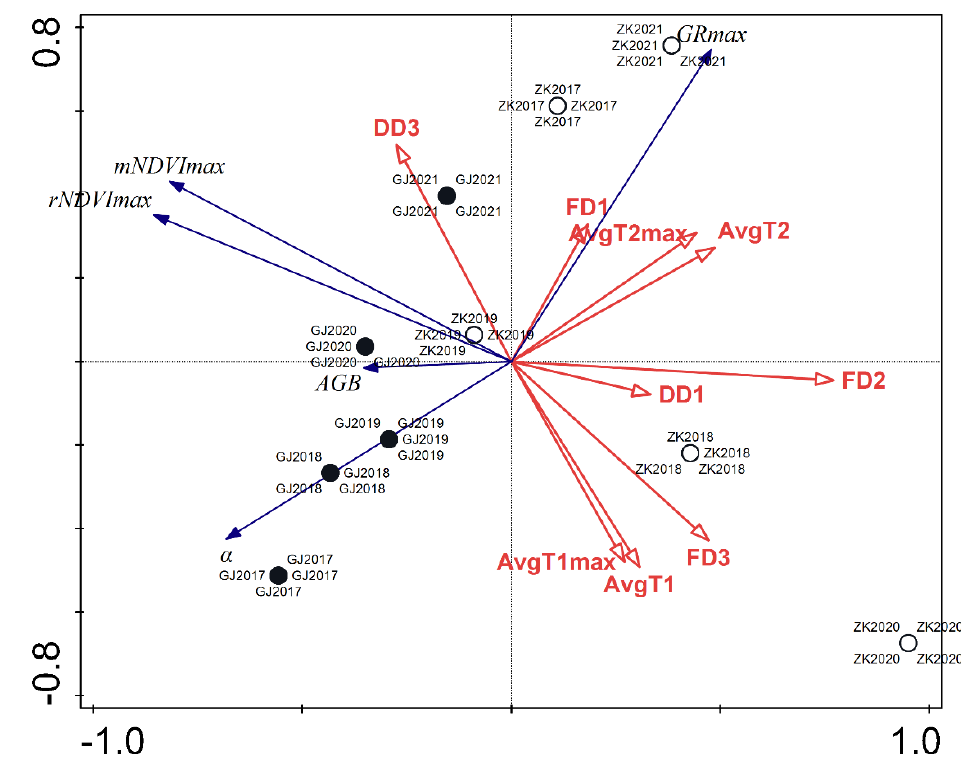
Figure 9. RDA triplot showing the relationship between model parameters and biomass with environmental variables from 2017 to 2021 for the littoral reed stand at Zadnji kraj and the riparian reed stand at Gorenje Jezero. Black and white circles indicate both locations depending on the year. Blue vectors indicate dependent variables and red vectors indicate independent variables. (GJ — Gorenje Jezero riparian stand; ZK — Zadnji kraj littoral stand; FD3 — number of flooded days during NDVI